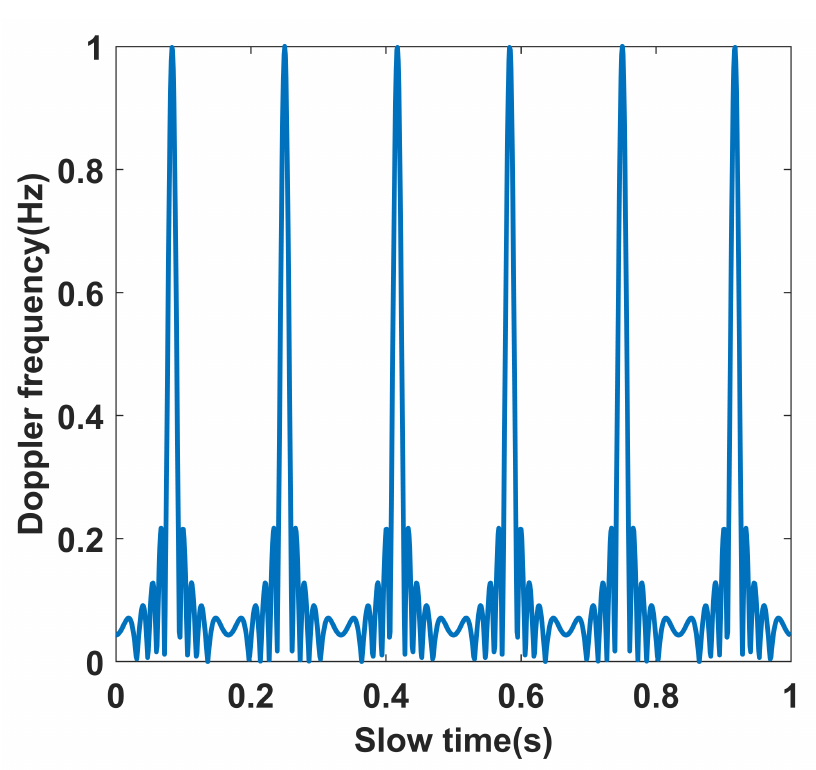
Figure 2. Echo signal in the slow time